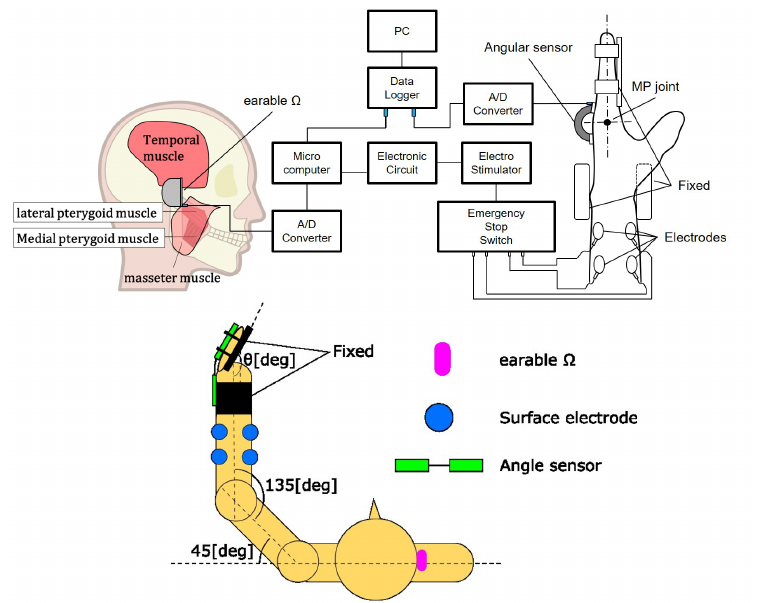
Figure 3. Upper figure shows the system configuration diagram. Lower figure shows an experimental setup for controlling the joint angle using earable Ω as an interface, top view. The stimulation at the surface electrode is via the emergency stop switch for the safety of